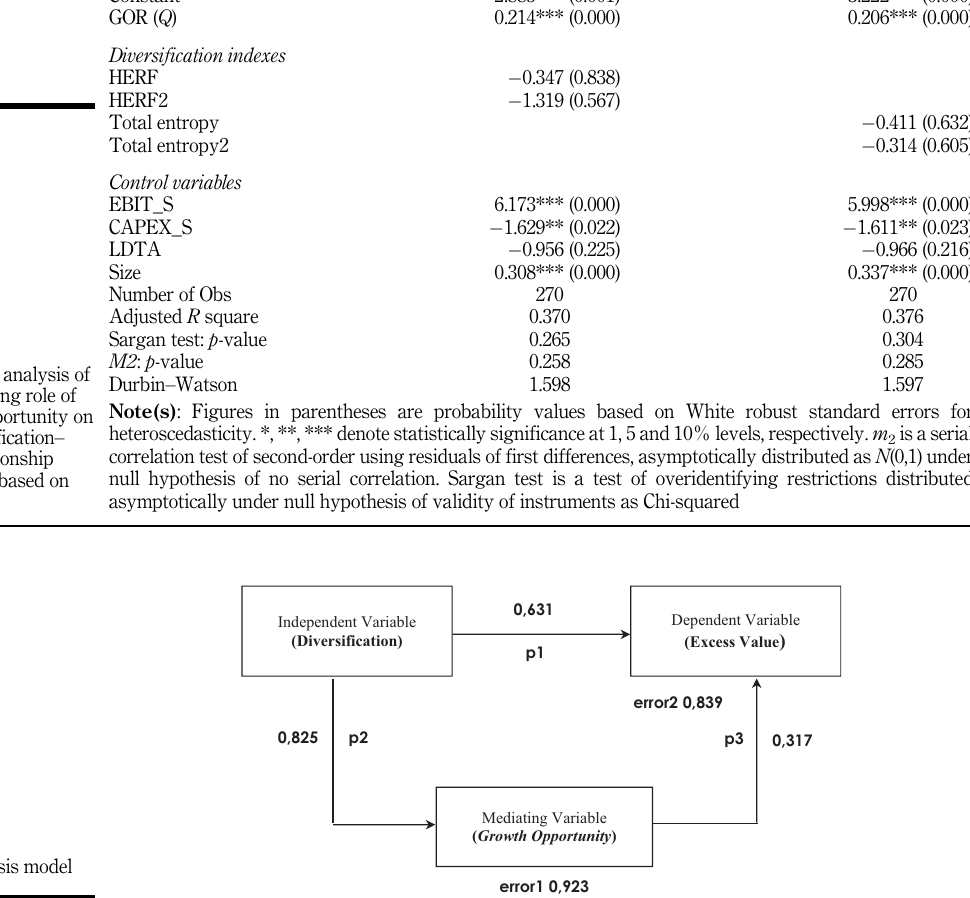
Figure 2. Path analysis